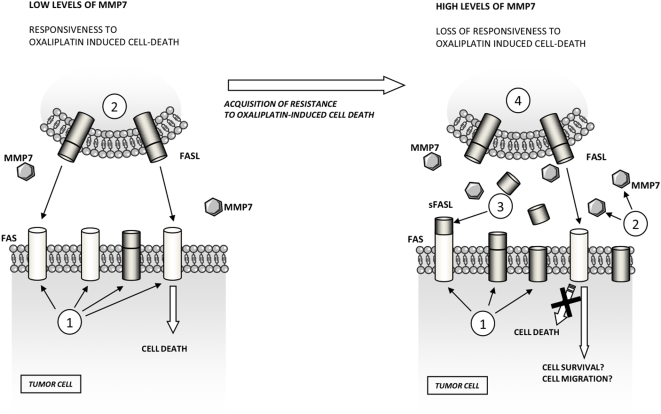
Mechanism of acquisition of resistance to oxaliplatin-induced cell death.A) In a tumor with low levels of MMP7 oxaliplatin is able to induce an upregulation of Fas receptor at the plasma membrane (1), allowing its activation by cells expressing FasL, such as cytotoxic cells or the surrender cells of the tumor (2). B) On the other hand, in cells with higher levels of MMP7, such as cells that have acquired resistance to oxaliplatin, the activation of Fas receptor is different. Oxaliplatin in these cells induce a stronger upregulation of FasL (1) that is shaded by MMP7 to generate sFasL (2). This sFasL binds to Fas probably inducing its activation (3). Fas receptor could, in turn, be shaded by MMP7, decreasing the availability of Fas at the cell surface (4), although the remaining Fas receptor could be activated by its ligand inducing pathways related to cell survival.